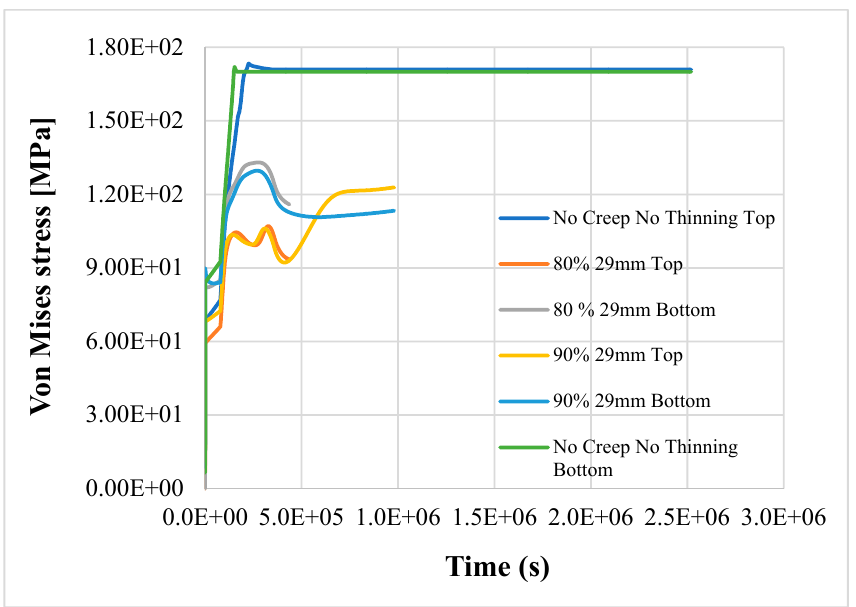
Figure 10. Top and bottom layers of equivalent von Mises stress in thinning—case 1 (reference), case 4, case 5.